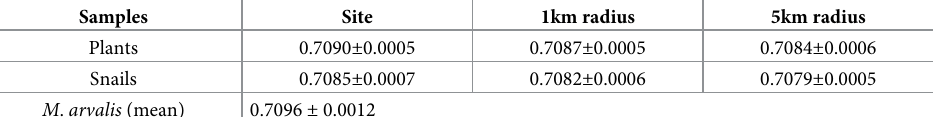
Table 3. Strontium baseline isotope data for the Fumane site and nearby regions based on modern plants, modern land snails and archaeological teeth of Microtus arvalis (common vole). Samples